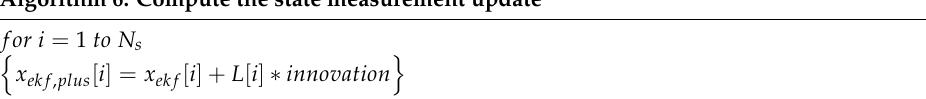
Algorithm 6: Compute the state measurement update